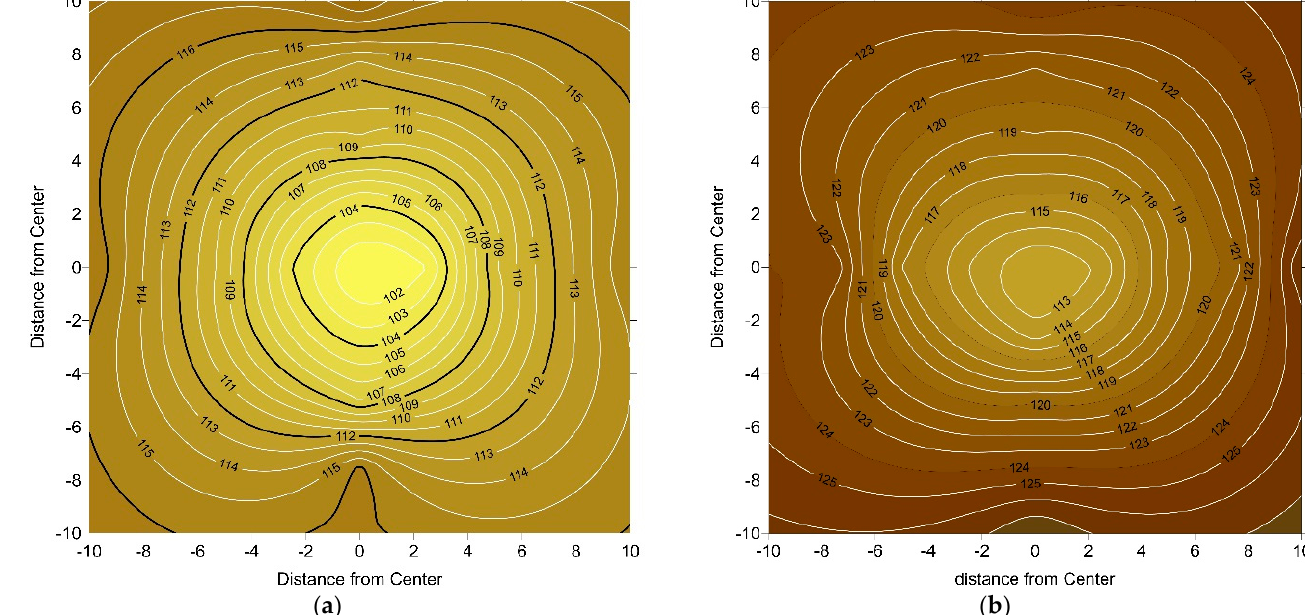
Figure 16. Color coded contour for the hardness values recorded on the TS of the Cu samples processed via ECAP through ( a ) 1-P and ( b ) 4-Bc at 200 °C.